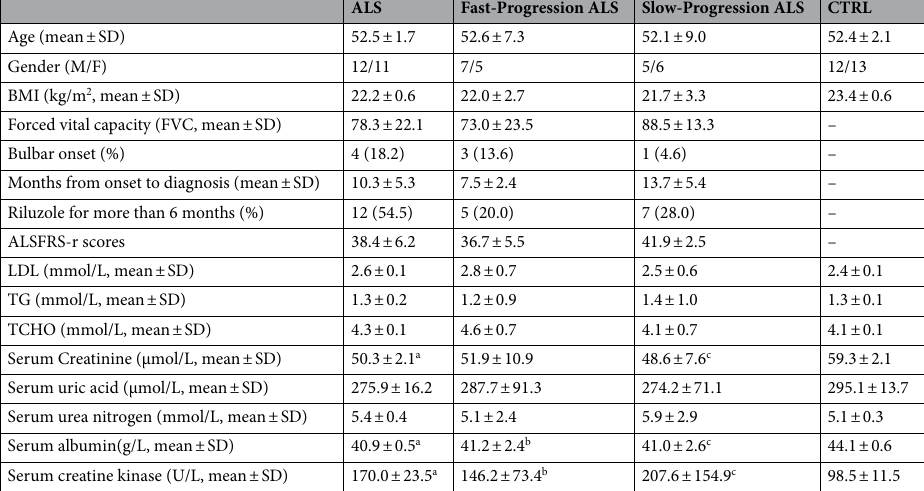
Table 1. Demographic characteristics of ALS patients and healthy subjects. a ALS versus CTRL, t -test, p < 0.05. b Fast-progression ALS versus CTRL, t -test, p < 0.05. c Slow-progression ALS versus CTRL, t -test, p <